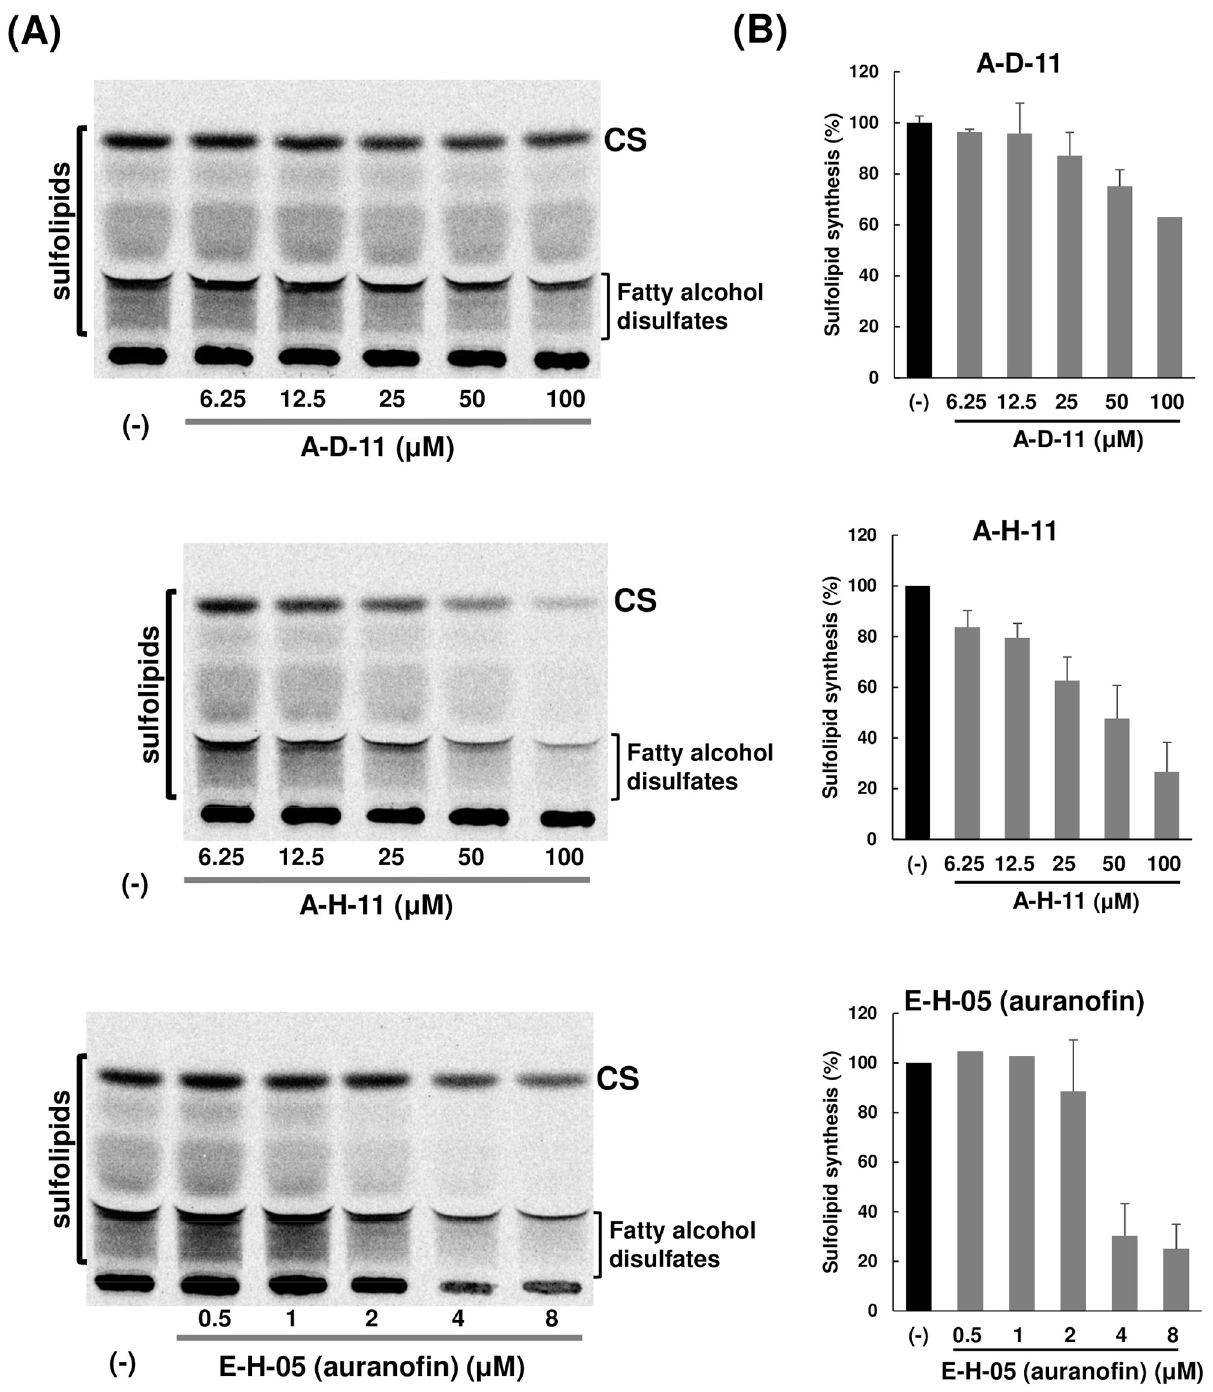
Fig 6. Sulfolipid synthesis in E . histolytica treated for 6 h with A-D-11, A-H-11, or E-H-05 (auranofin). (A) Autoradiography of HPTLC of methanol extracts of [ 35 S]-labeled trophozoites cultivated in the presence of different concentrations of each compound. The autoradiographic images shown are representative of the results from three independent experiments. (B) Quantitation of sulfolipids synthesized in trophozoites cultivated in the presence of different concentrations of each compound. The data were calculated from the autoradiography image and are expressed relative to that in a solvent-treated control (set as 100%) after normalizing to total synthesized sulfolipids and total cell protein. Data shown are the mean with error bar (SD from the mean) from three independent experiments. Samples for A-D-11 and A-H-11 treatments were originally run in a single TLC plate, which included a lane for a control sample, and the obtained image was split into two parts for ease of comparison; therefore, the single control lane was used to calculate the relative values for both A-D-11 and A-H-11.